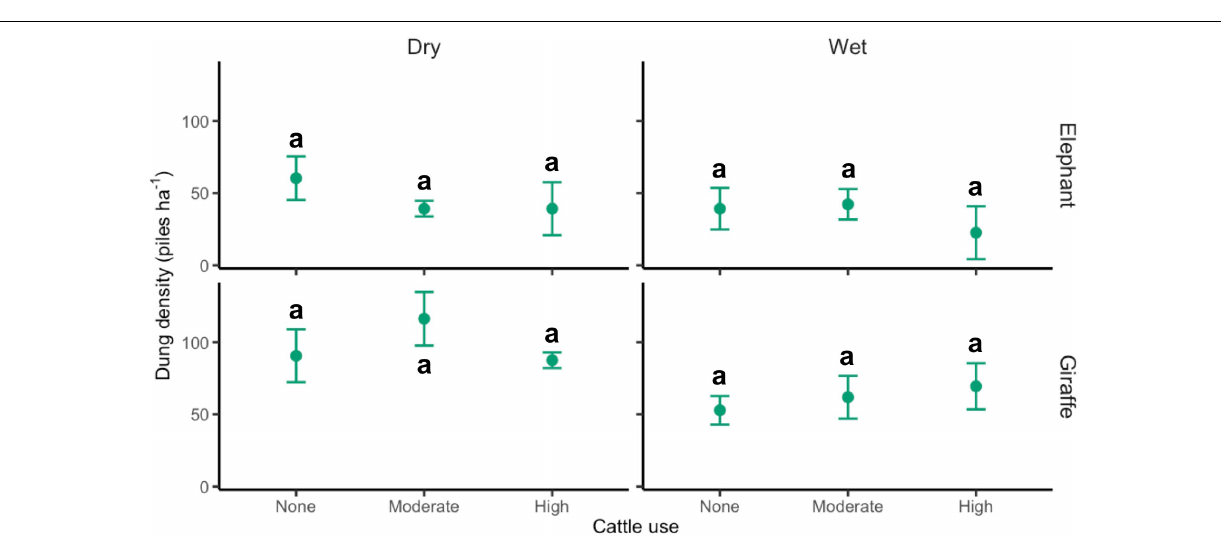
FIGURE 2 | Effects of cattle stocking rate on wild megaherbivore habitat use ( M ± 1 SE ). Within megaherbivore species, treatments not sharing letters are significantly different ( p < 0.05) based on Tukey’s post hoc